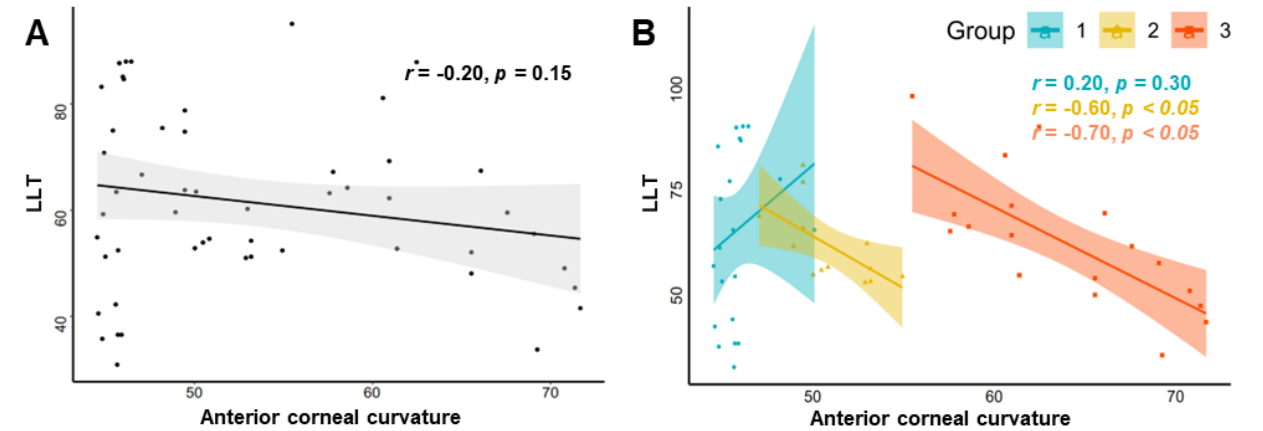
Figure 2. Partial correlogram of LLT and anterior corneal curvature. ( A ) Correlation of the overall KC patients. ( B ) Correlation of the KC patients with different severity .